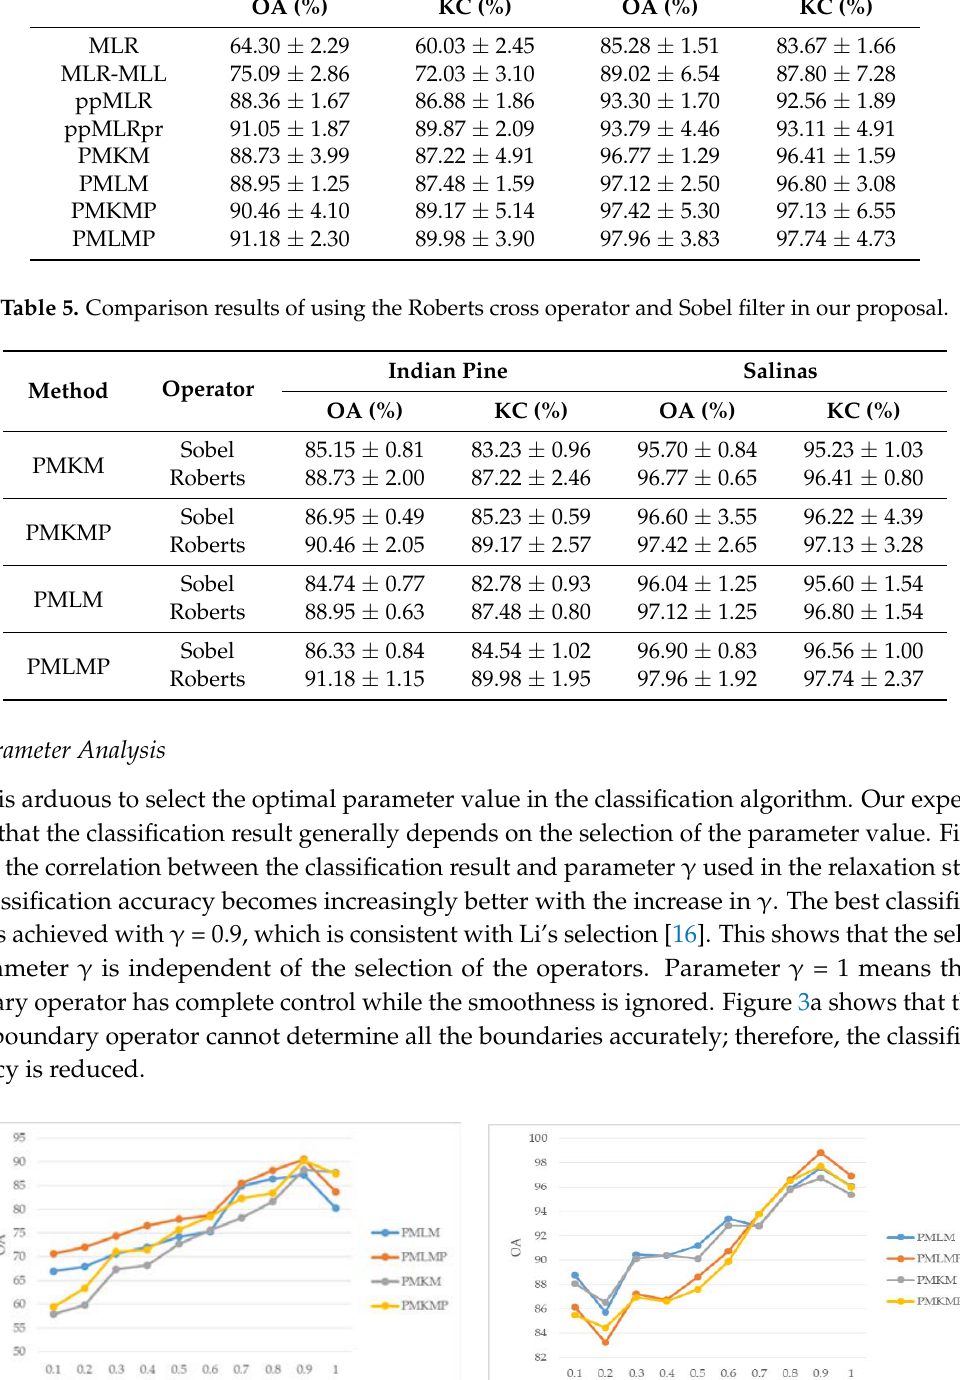
( b ) Figure 5. The relation between the classification result and parameter k. ( a ) Indian Pines; ( b ) Salinas. 4. Conclusions In this study, we developed a novel semi-supervised method for HSI classification based on the DPR strategy and pre-classification technique. Using the DPR strategy in pre-processing and post- processing achieves the purpose of denoising and improving the classification accuracy, respectively. The pre-classification technique is aimed to address the problem of limited training samples in a semi-supervised classification. Our experimental results using the Indian Pines and Salinas datasets show that in the DPR strategy, the substitution of the Roberts cross operator with the Sobel filter can yield better classification results. The comparative test results show that the proposed method is superior to several existing methods. In particular, the proposal can provide perfect classification results for limited training samples. Author Contributions: D.H., F.X. and D.L. conceived of and designed the experiments; D.H. and F.L. performed the experiments; J.Y., D.L., and D.H. analyzed the data and developed the graphs and tables; and F.L. and F.X. wrote the paper. Funding: This work was supported by the National Natural Science Foundation of China (grants 41771178 and 61772252).